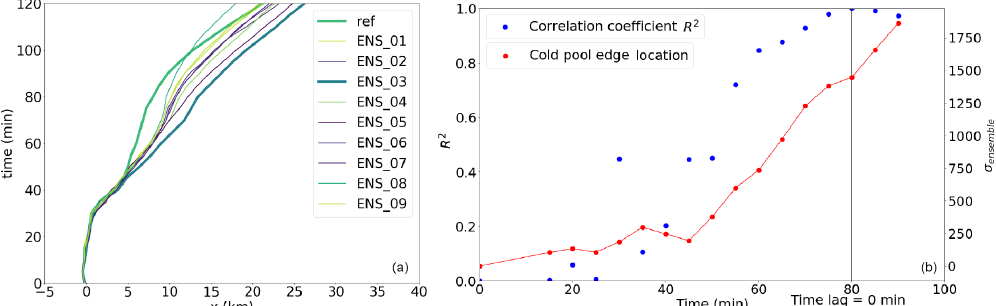
Figure 6. (a) Hovmöller diagram of cold pool edge propagation, with colours in the order of their initial z i , with low interfaces in lime and high interfaces in purple (reference and ENS-03: bold). (b) R 2 of time lag correlations as a function of simulation time (indicated) for the cold pool position among 10 ensemble members, with the position at t = 80min as reference correlation of 1 (blue; left y axis). Also shown is the temporal evolution of the standard deviation of the cold pool edge position in m (red; right y axis). The points at t = 5 and 10min are omitted, as there is no variability in cold pool edge location among the ensemble members